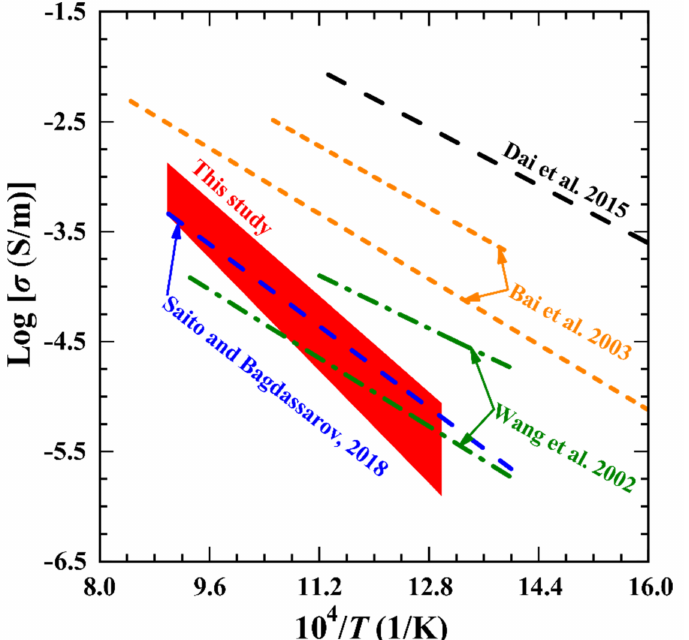
Figure 10. Electrical conductivities of dry hot-pressed sintering gabbro with various mineralogical proportions at the pressure of 1.0 GPa (red shaded area) compared with the previous